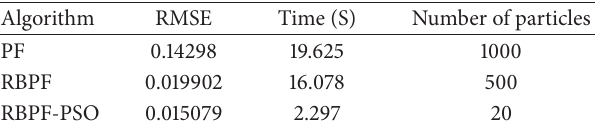
Table 1: Performance comparison between PF, RBPF, and RBPF-